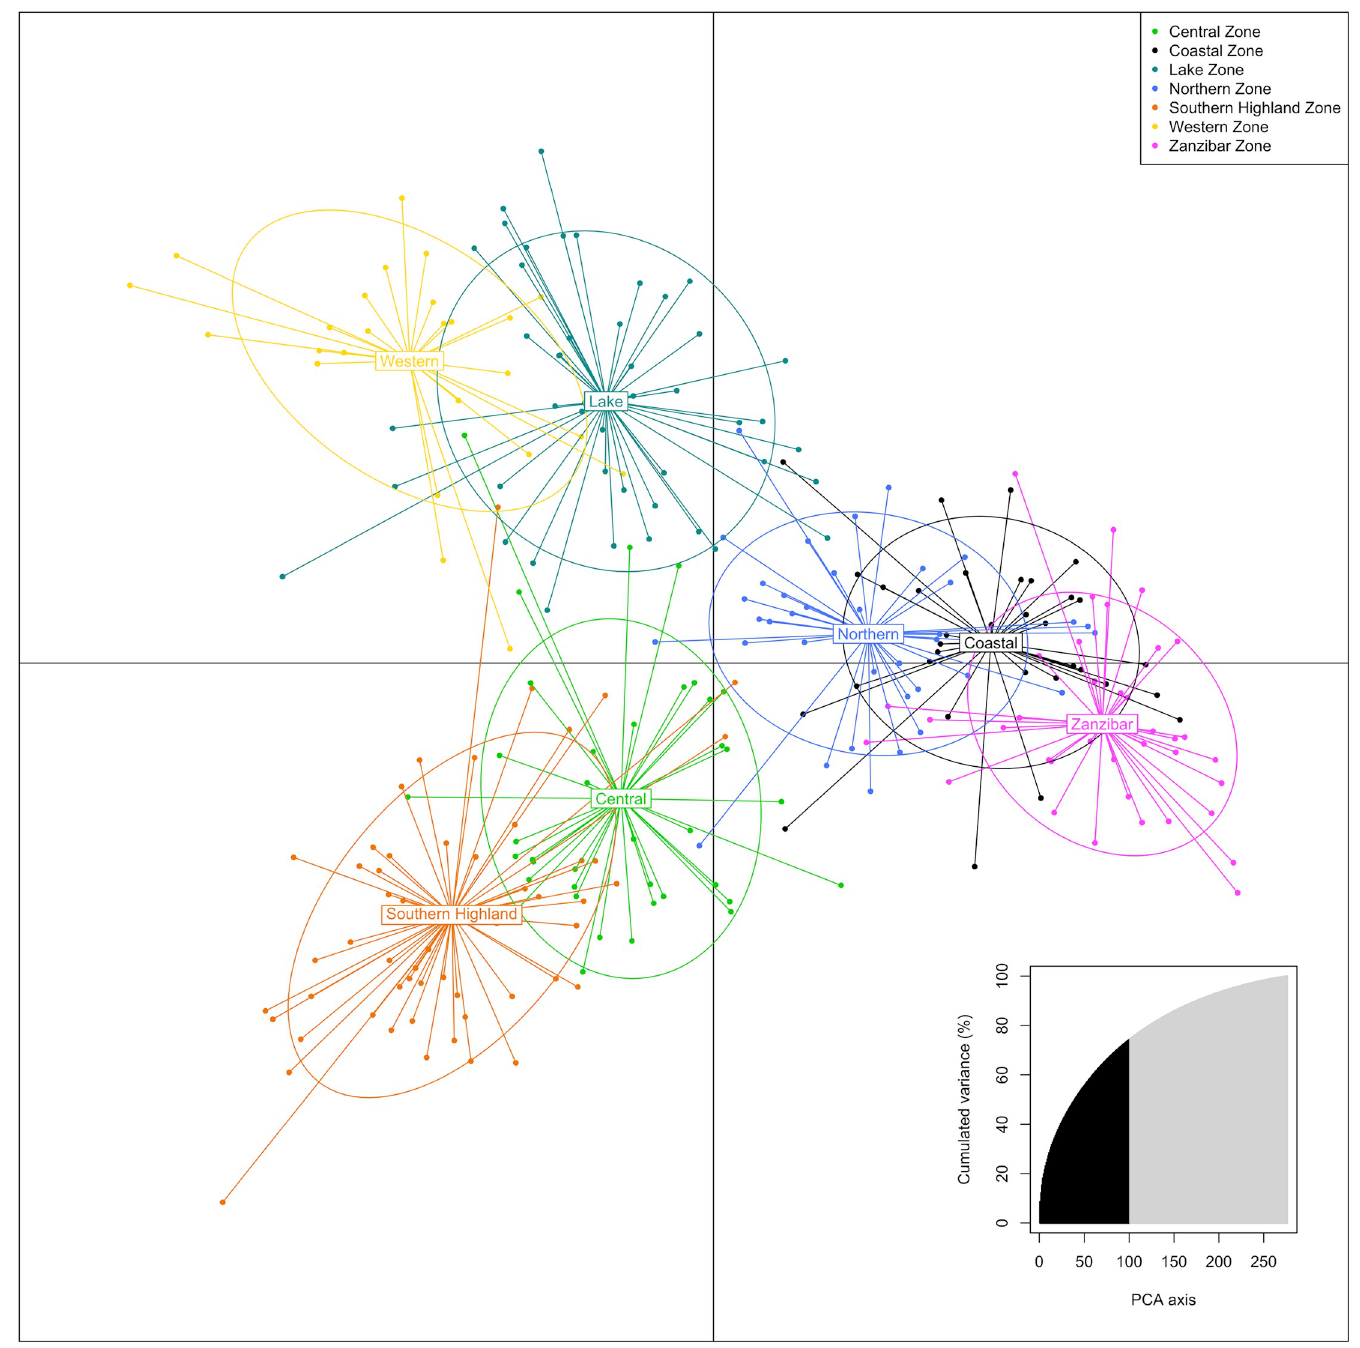
Fig 3. DAPC plot showing the relationship of cassava landraces from seven zones of Tanzania. The number of axes retained in the Principal Component Analysis (PCA) were 100 which account for 74.2% of the variation (inset). https://doi.org/10.1371/journal.pone.0255326.g003 selected by farmers based on a range of criteria, ranging from food security, preferred cooking and eating quality traits and market demand [44]. The existence of these landraces is now threatened not only by virus diseases (CBSD and CMD), but by the influx of a few disease- resistant, higher yielding improved cultivars [44]. This is likely to reduce the diversity of